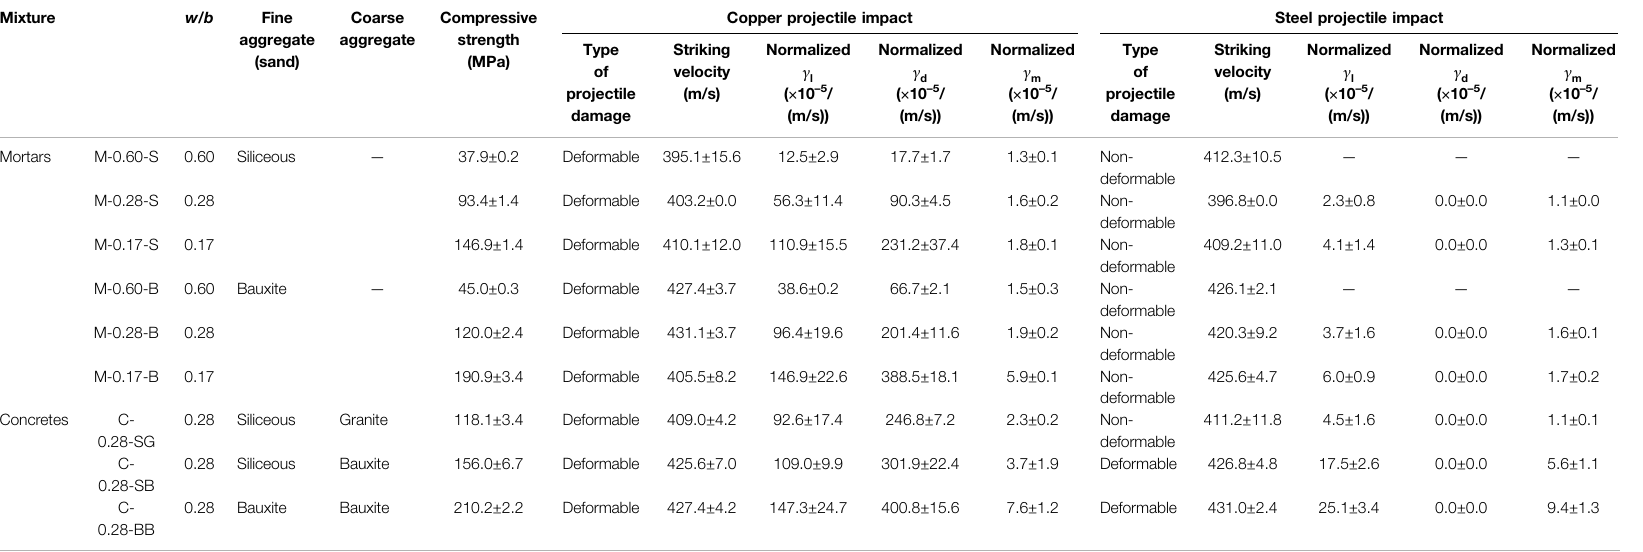
TABLE 5 | Summary of the c l , c d , and c m of copper and steel projectiles after HVPI tests.